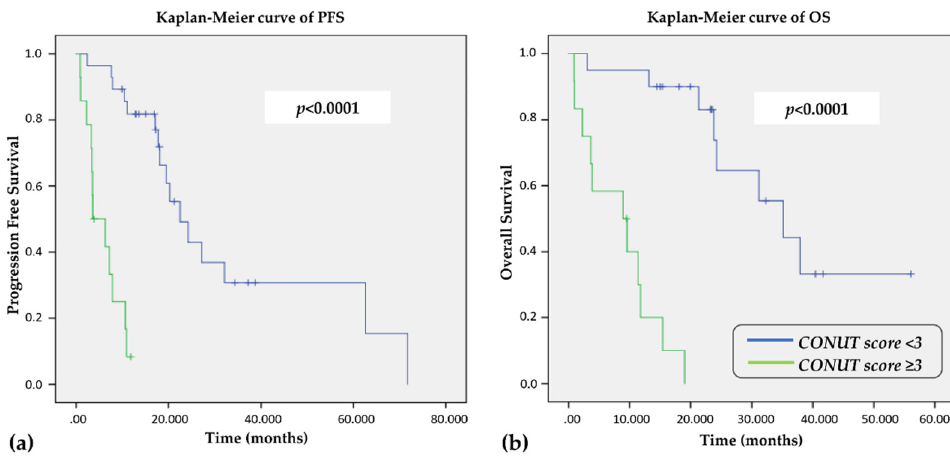
Figure 2. Kaplan–Meier curve for PFS ( a ) and OS ( b ) according to the CONUT cut-off of 3.